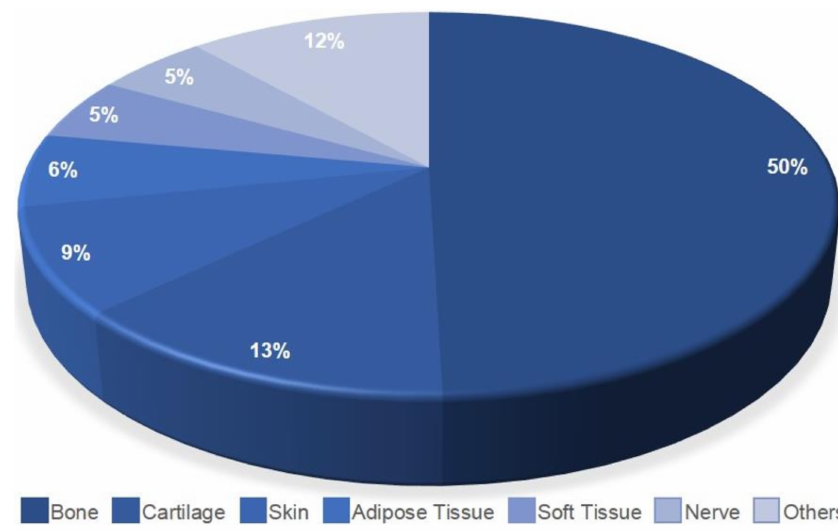
Figure 11. Types of applications in AD-MSCs for regenerative